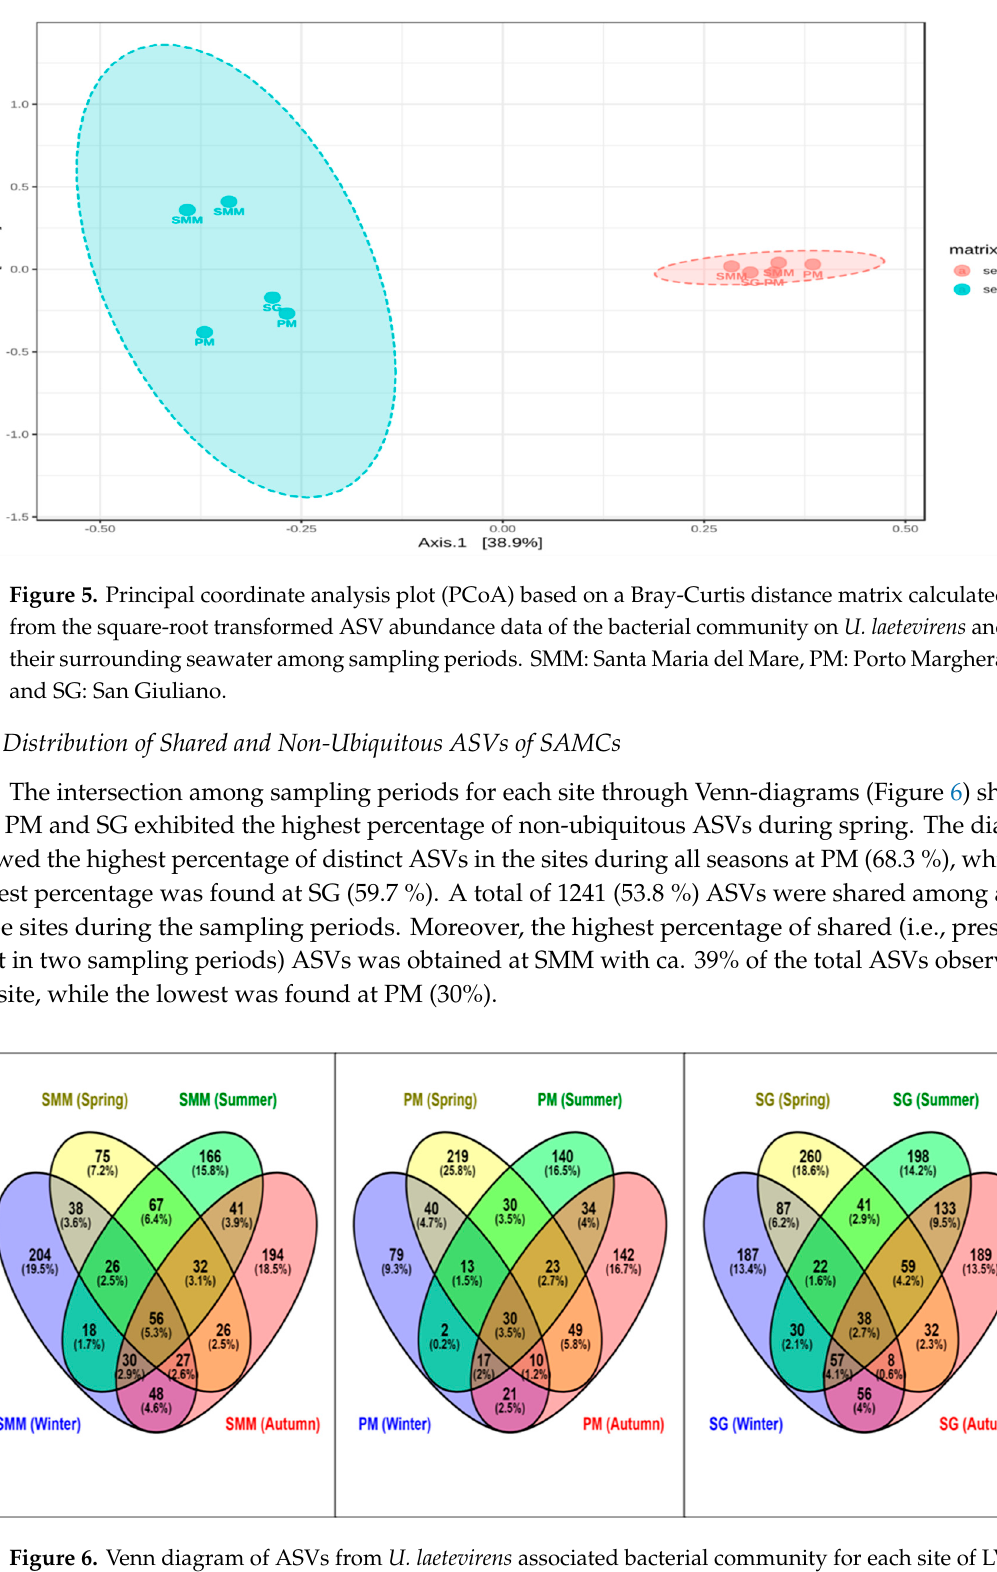
Figure 6. Venn diagram of ASVs from U. laetevirens associated bacterial community for each site of LV among sampling periods. SMM: Santa Maria del Mare, PM: Porto Marghera, and SG: San Giuliano.